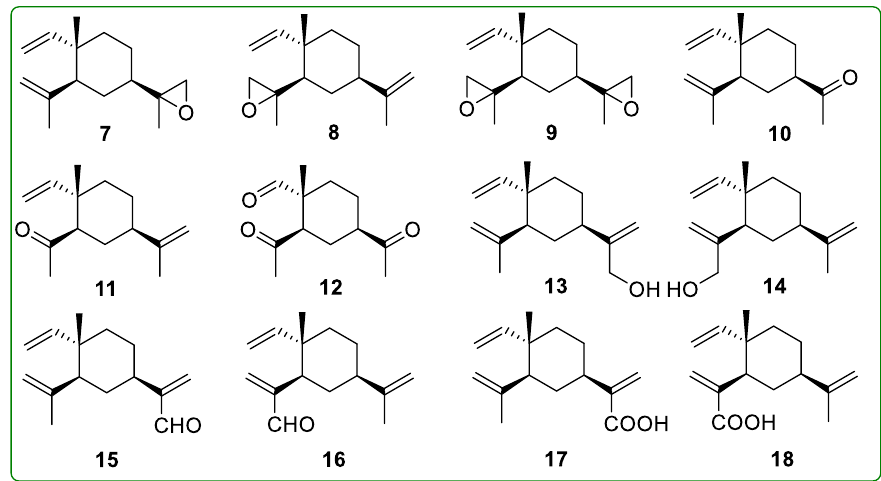
Figure 4. Chemical structures of β -elemene oxidation derivatives 7 – 18 .